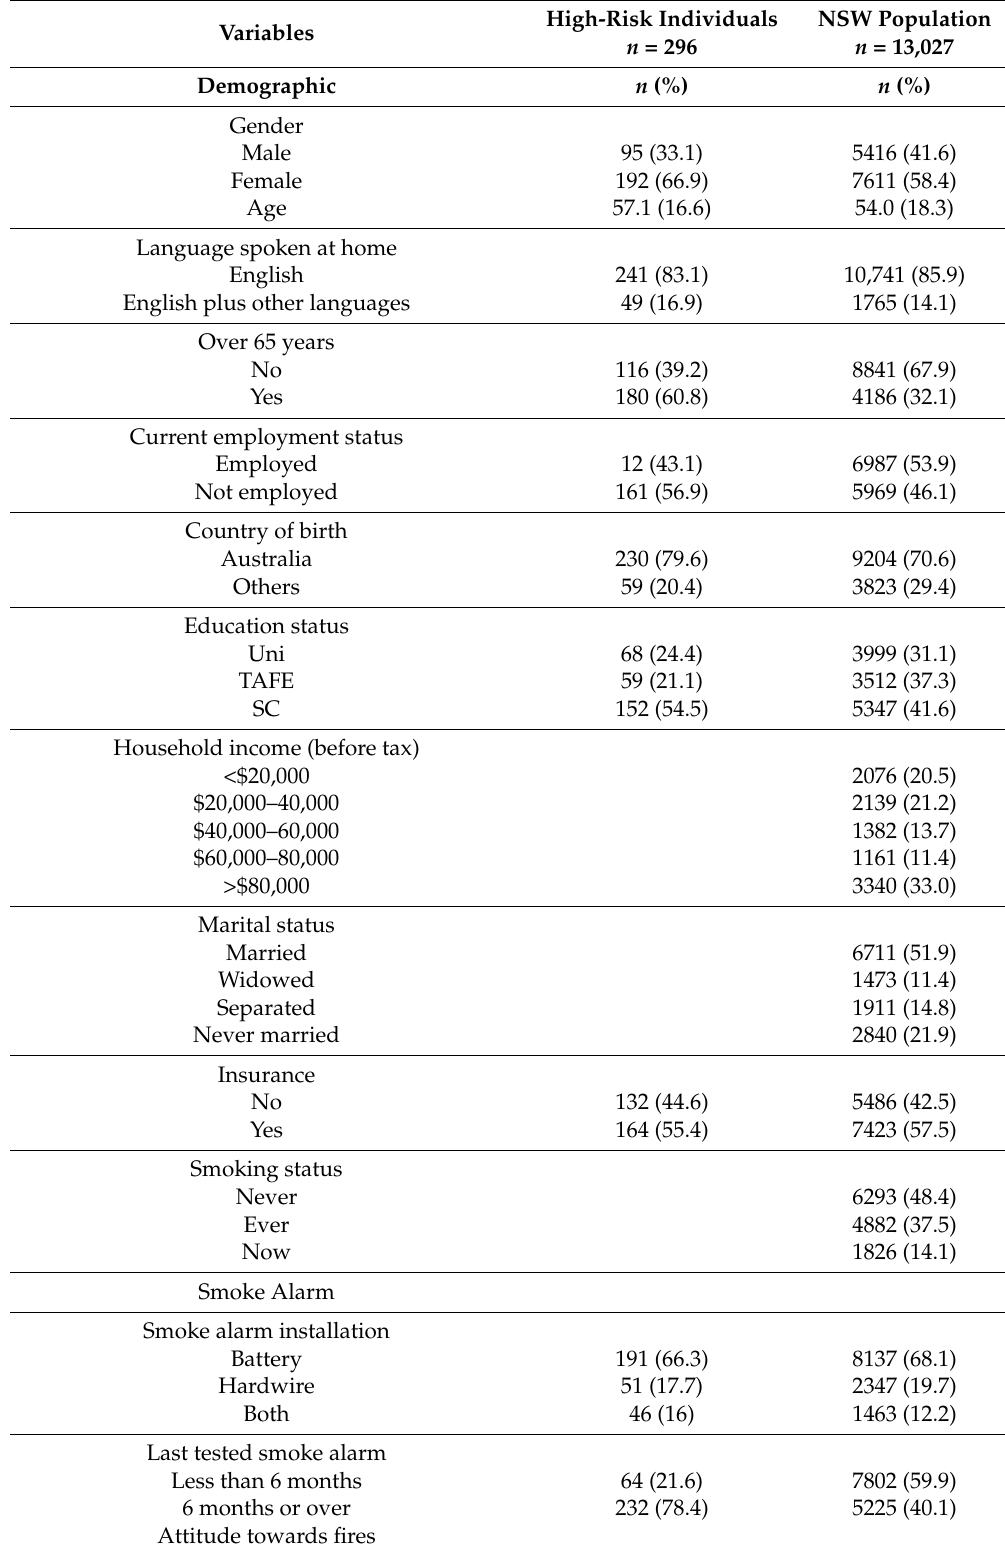
Table 1. Characteristics of the study